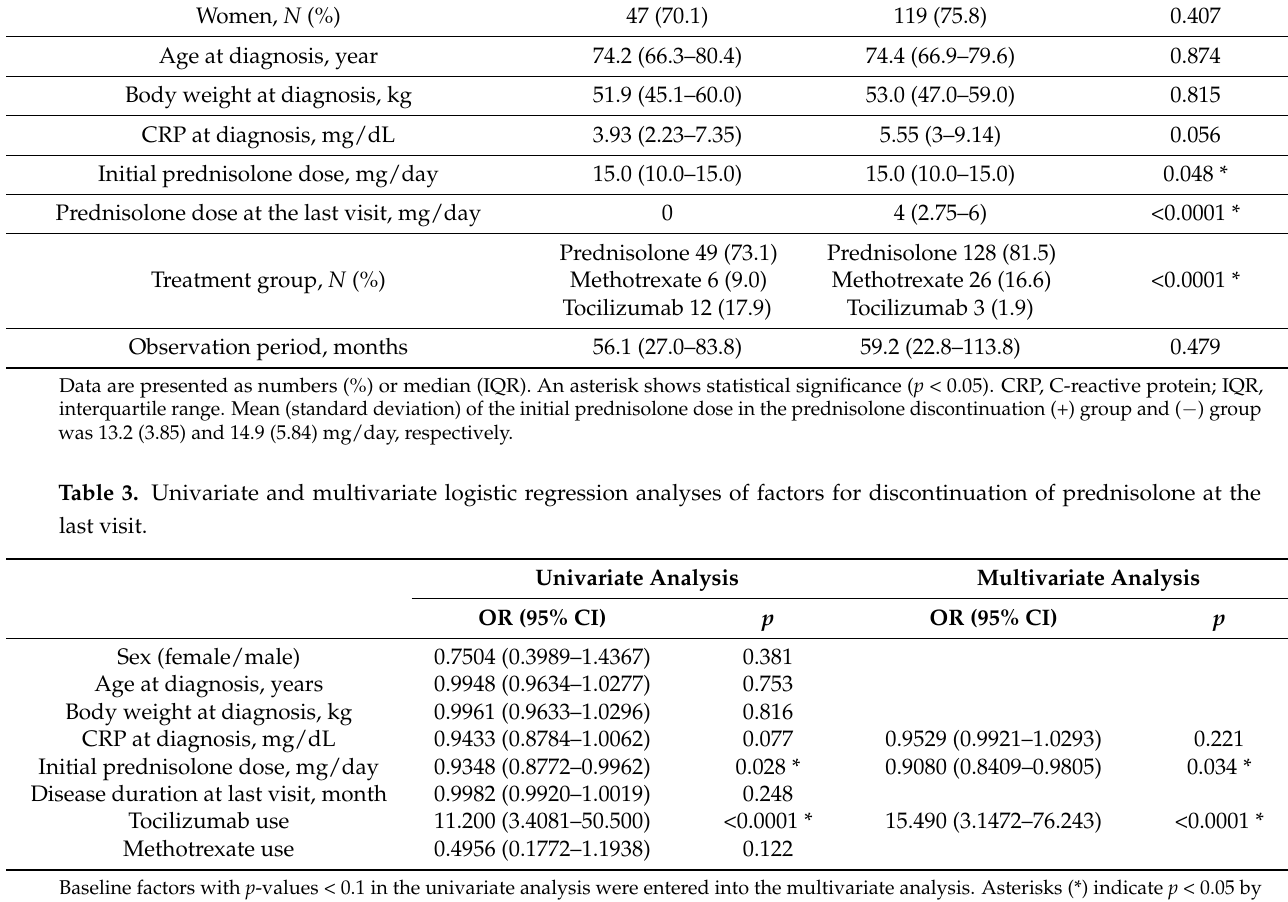
Table 2. Patient characteristics stratified according to prednisolone discontinuation at the last visit. Prednisolone Discontinuation at the Last Visit (+) N = 67 ( − ) N = 157